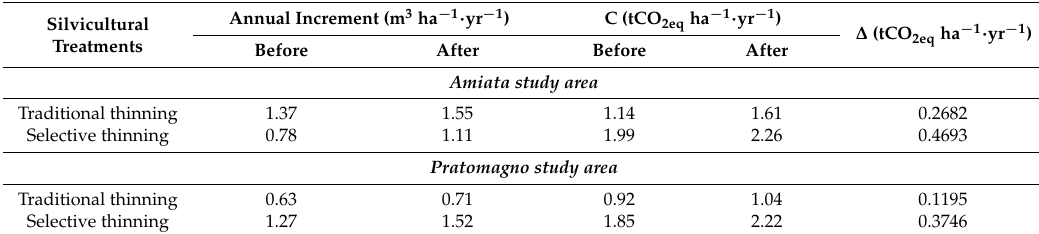
Table 3. Change in carbon sequestration ( ∆ ) after thinning in the two study areas. Silvicultural